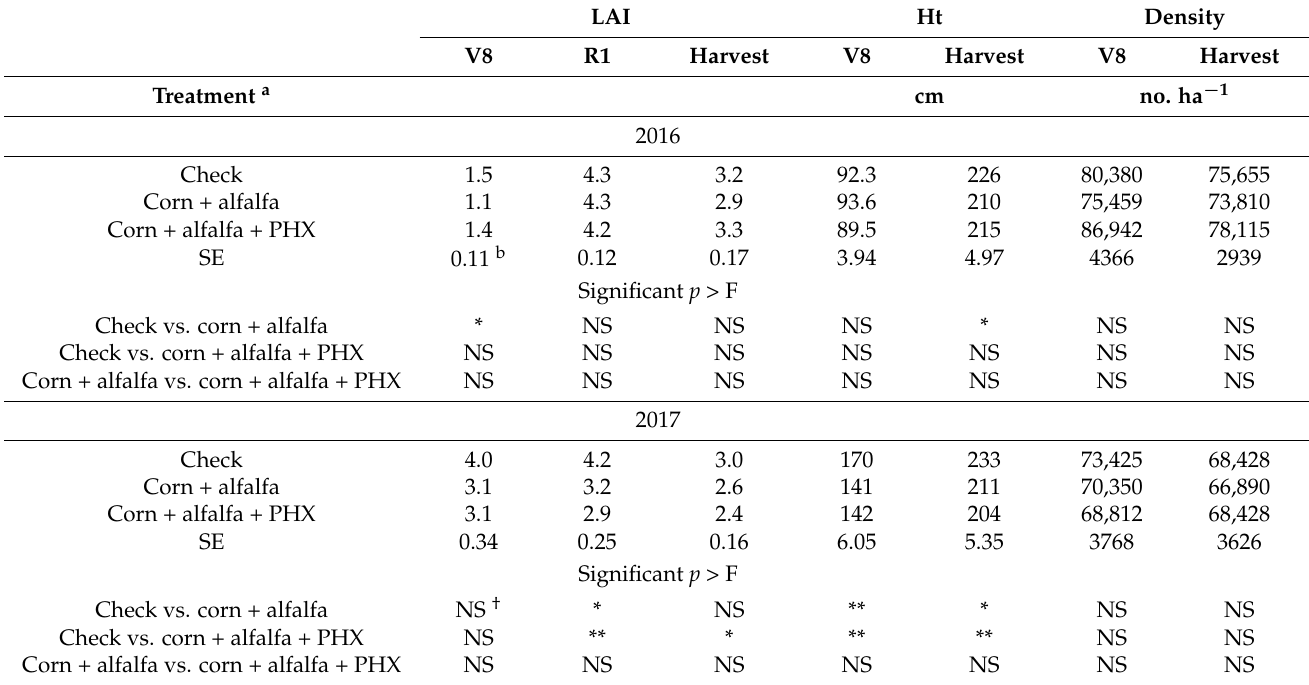
Table 4. Corn leaf area index (LAI), plant height (Ht), and plant density in response to alfalfa intercropping treatments at three corn growth stages (V8, R1, harvest (R6) for experiments started in 2016 and 2017 at Boone, IA, USA.